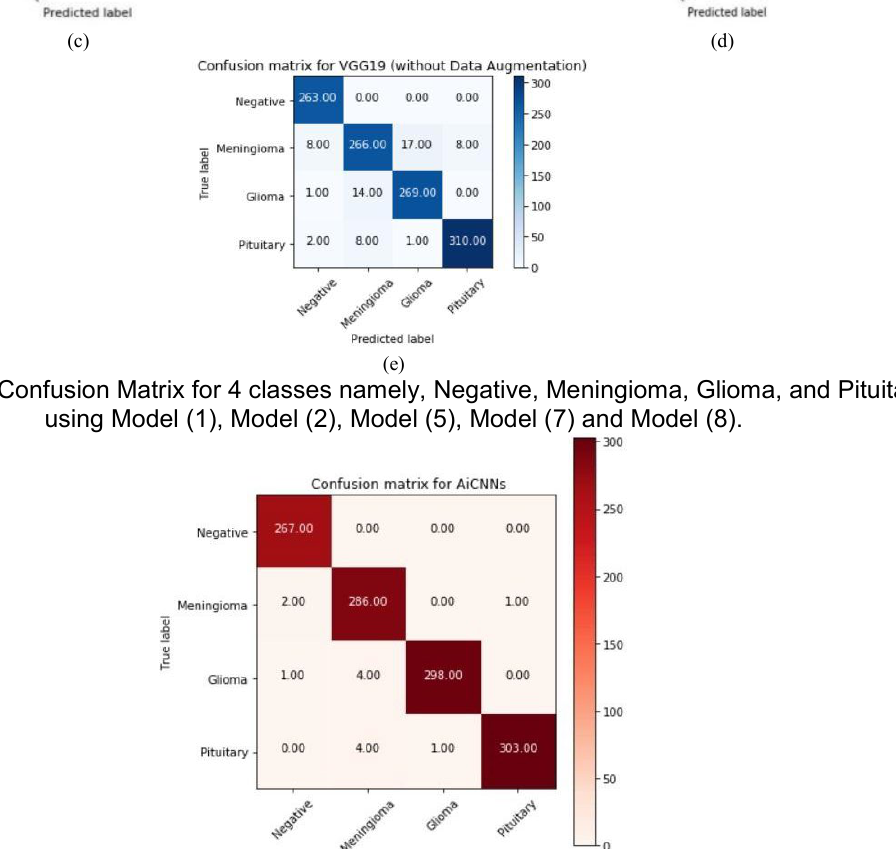
Figure 14. Confusion Matrix for 4 classes, namely, Negative, Meningioma, Glioma, and Pituitary when using AiCNNs (i.e. Artificially integrated Convolutional Neural Networks) Model.